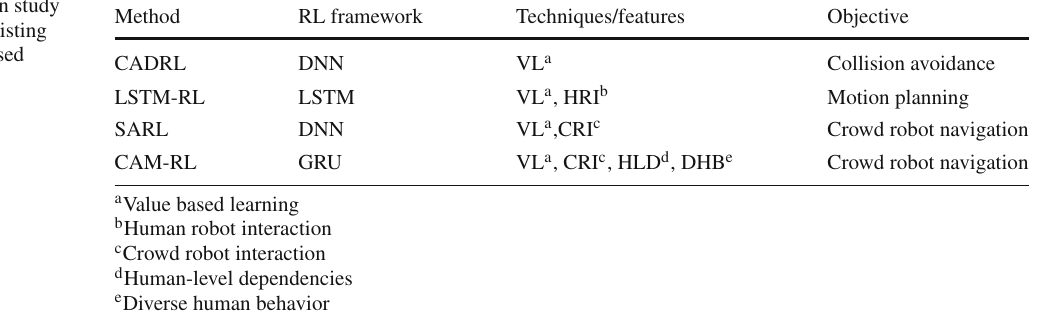
Table 1 The comparison study of key features of the existing methods with the proposed method